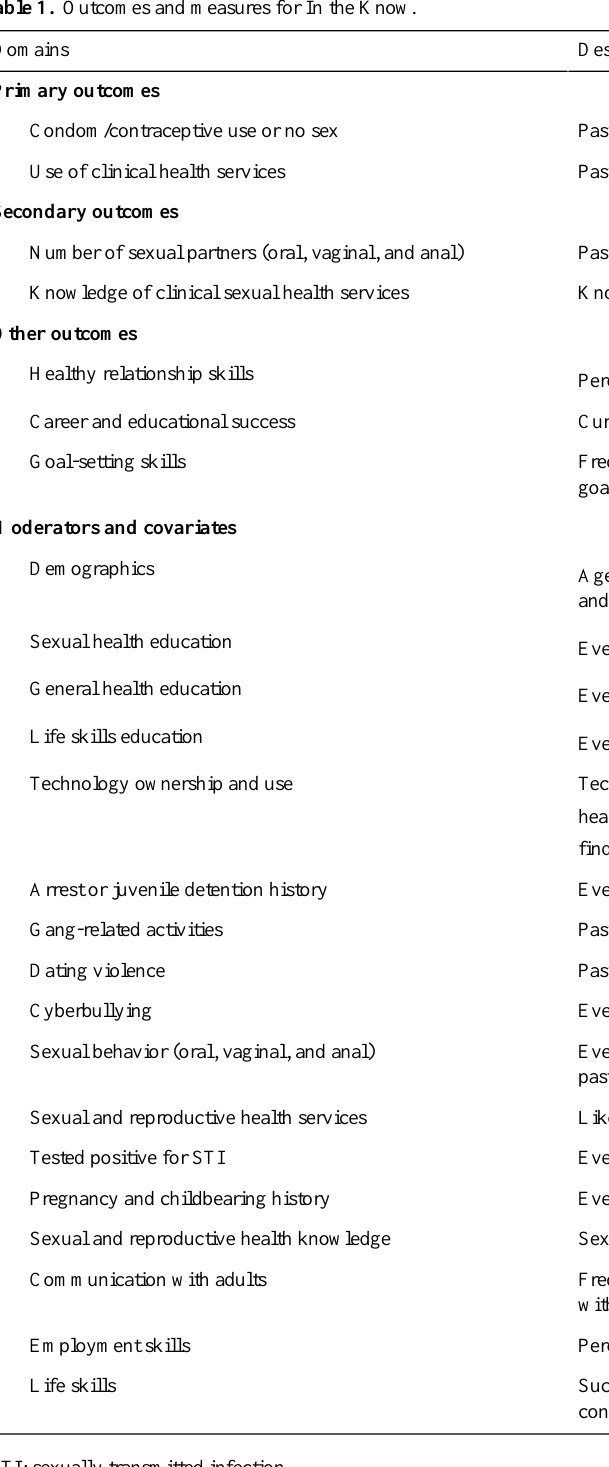
Table 1. Outcomes and measures for In the